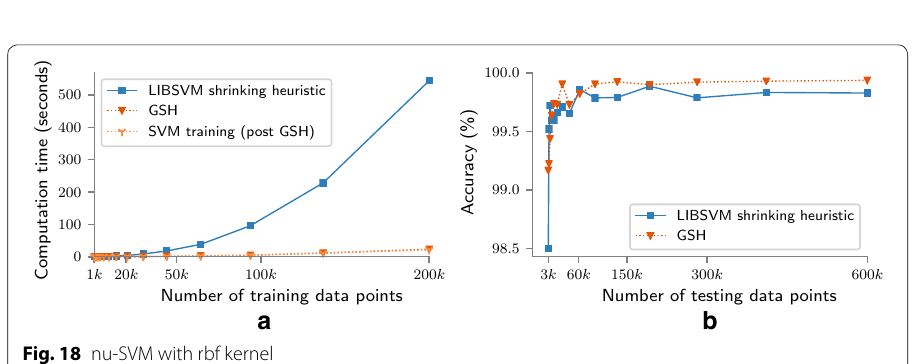
Fig. 18 nu-SVM with rbf